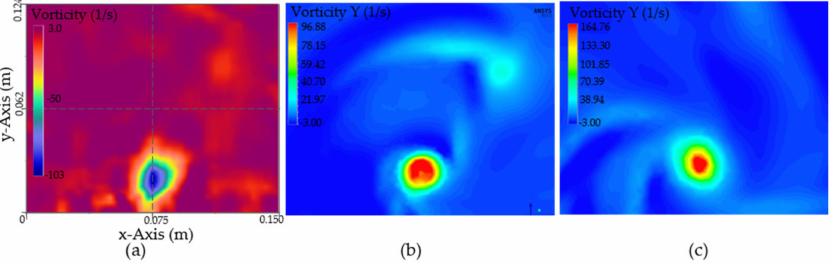
Figure 9. Comparison of vorticity: ( a ) PIV; ( b ) RANS-CFD (transient/SST turbulence model); ( c )